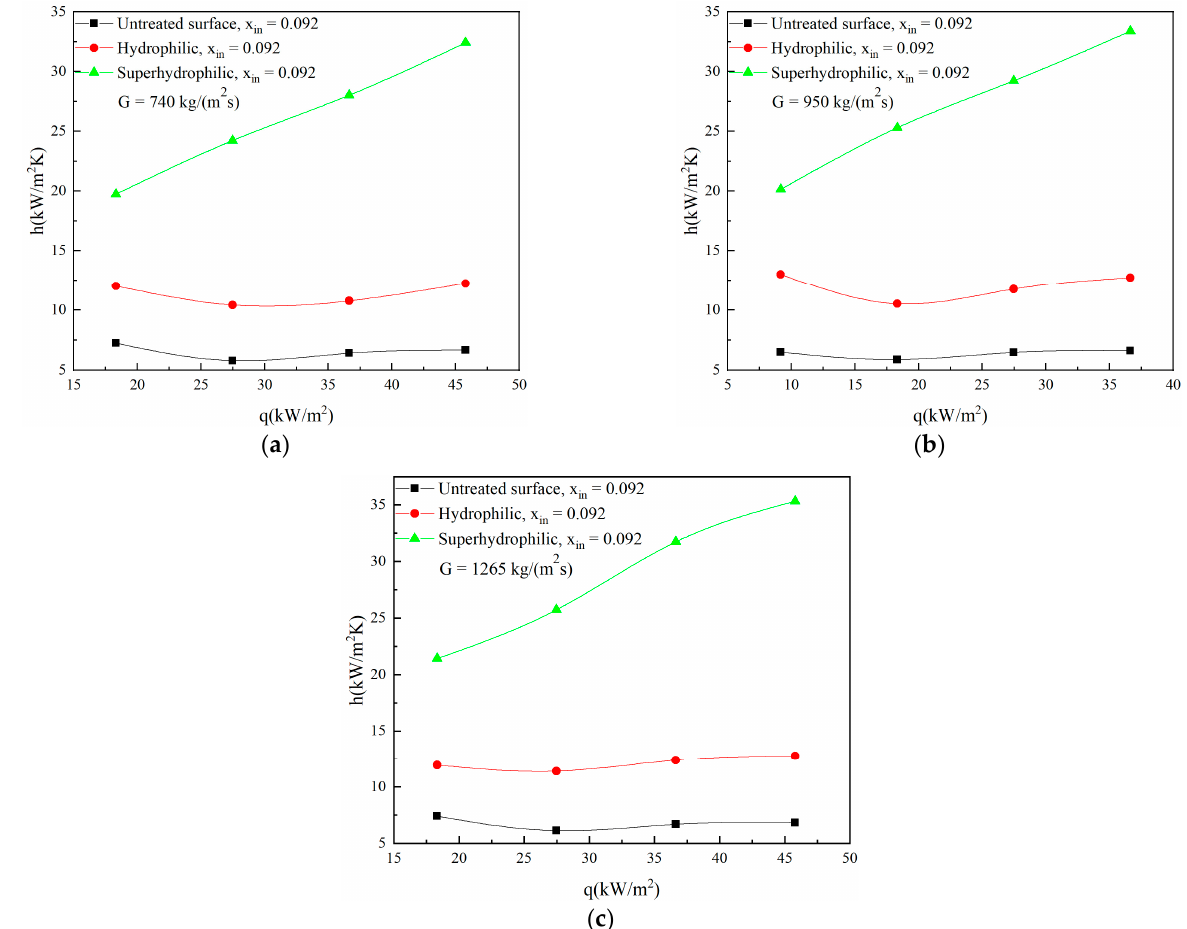
Figure 3. The effect of surface wettability on average heat transfer coefficients with the increase of heat fluxes for ( a ) G = 740 kg/(m 2 s), ( b ) G = 950 kg/(m 2 s), ( c ) G = 1265 kg/(m 2 s).